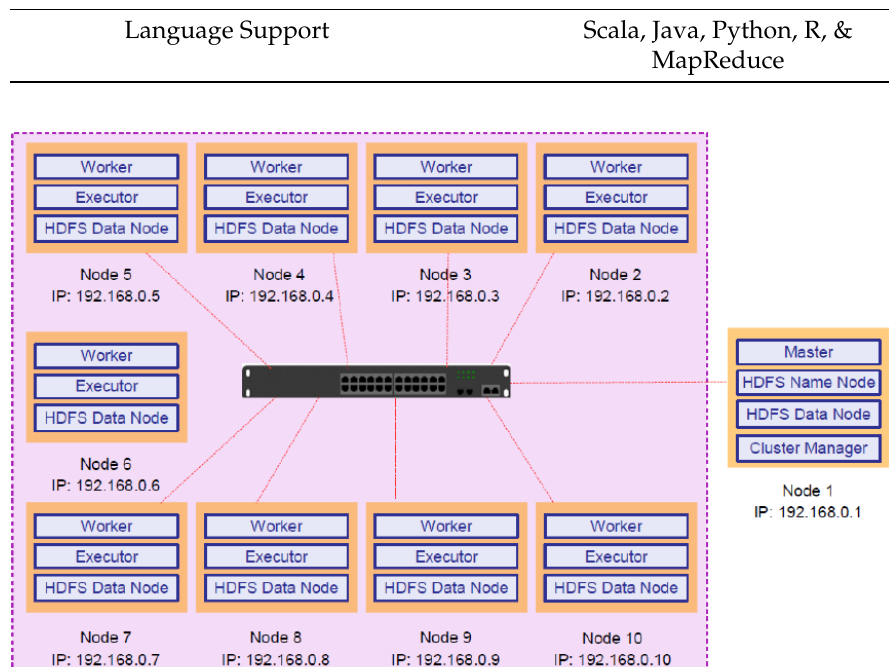
Figure 2. HPDA cluster